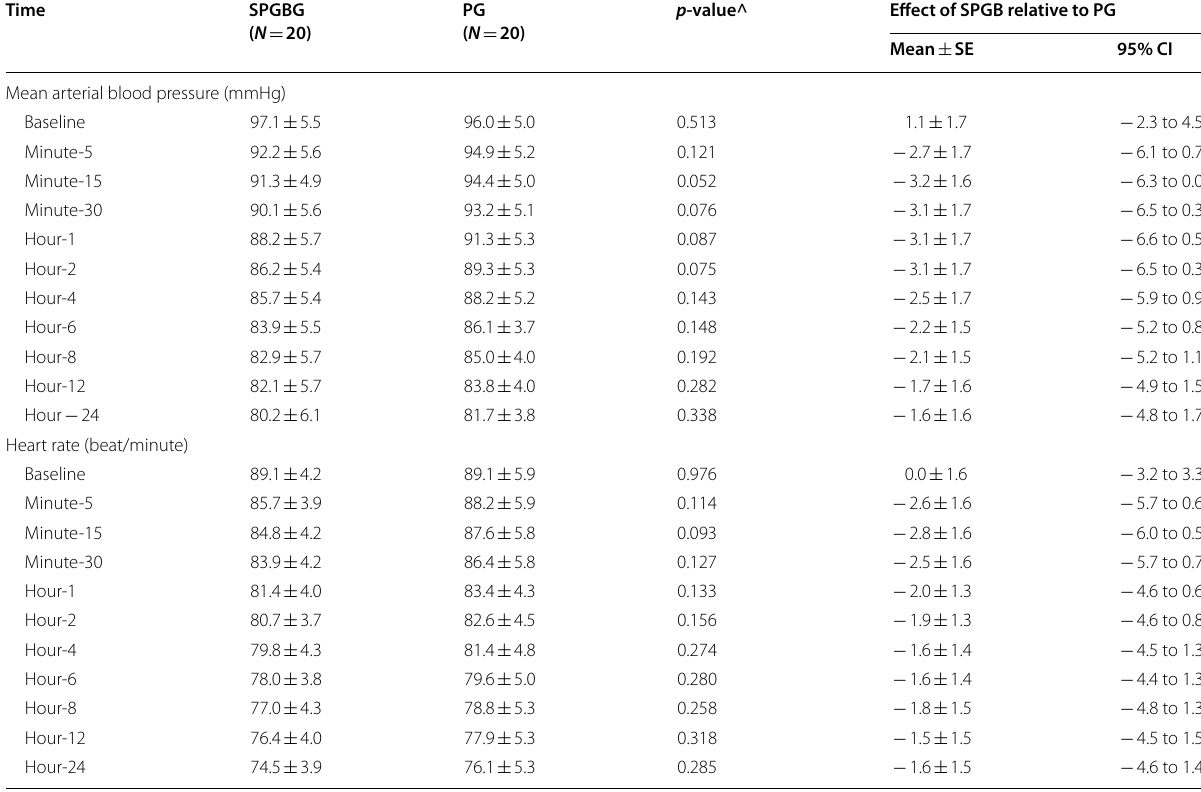
Table 2 Comparison regarding mean blood pressure and heart rate